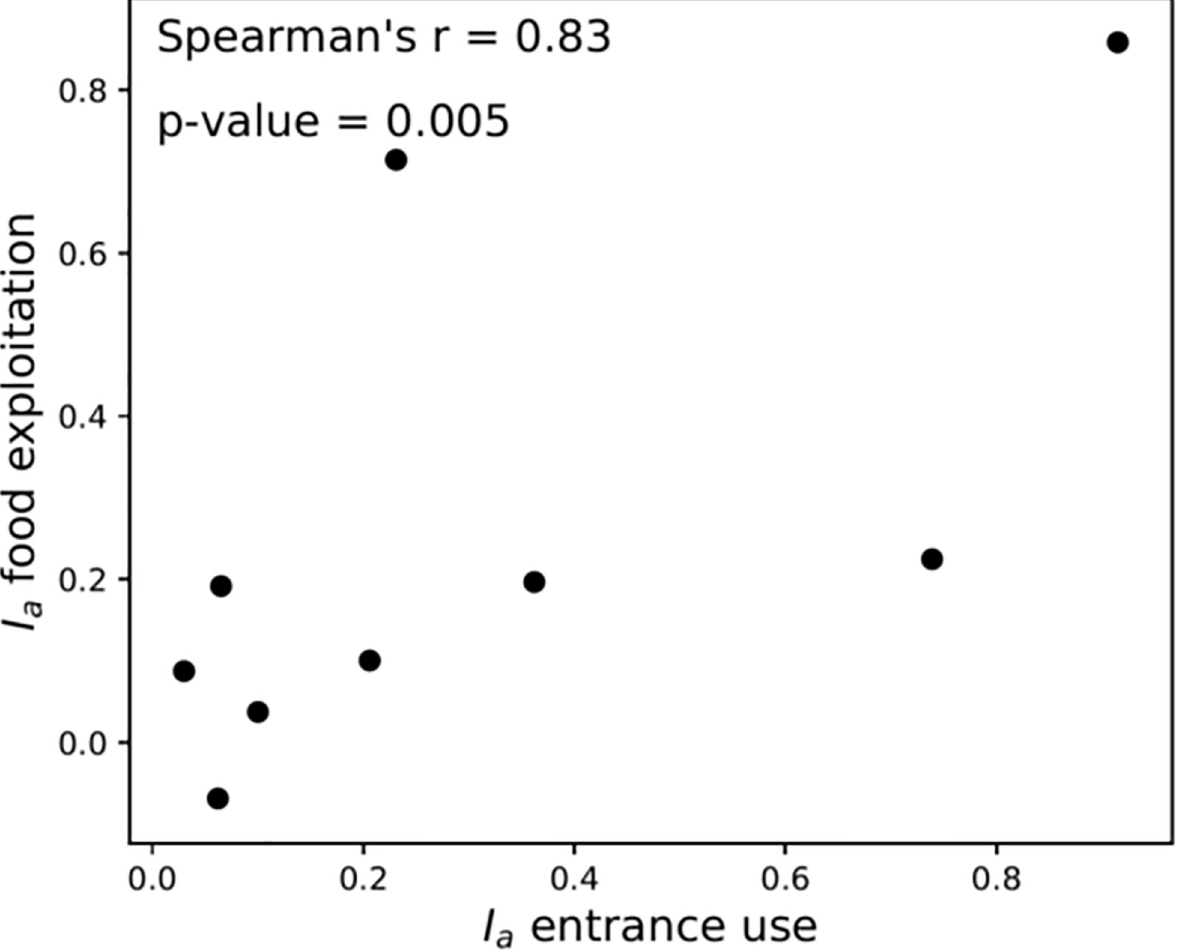
Fig 7. Asymmetry in the exploitation of feeders is correlated to asymmetry in the entrance use. Asymmetry in the entrance use ranged from 0 (symmetrical use of entrances) to 1 (use of only one entrance) after 20 min of experiment. Asymmetry of the resource exploitation was measured at the end of the experiment and ranged from 1 (all ants at the 1M source) to -1 (all ants at the 0.1M source). Spearman’s correlation, n =